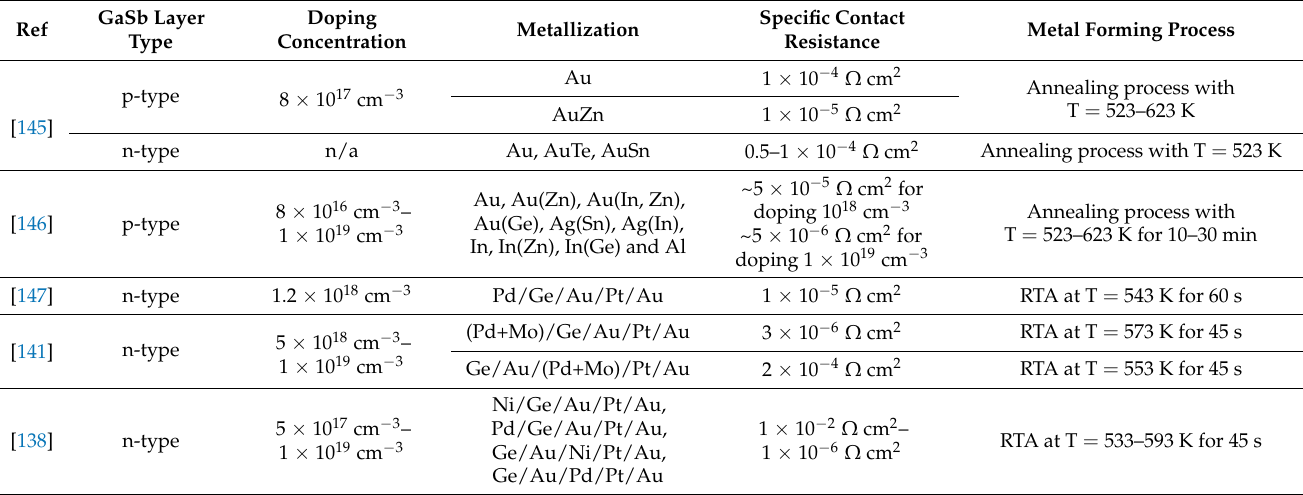
Table 3. The reported metal contact optimization